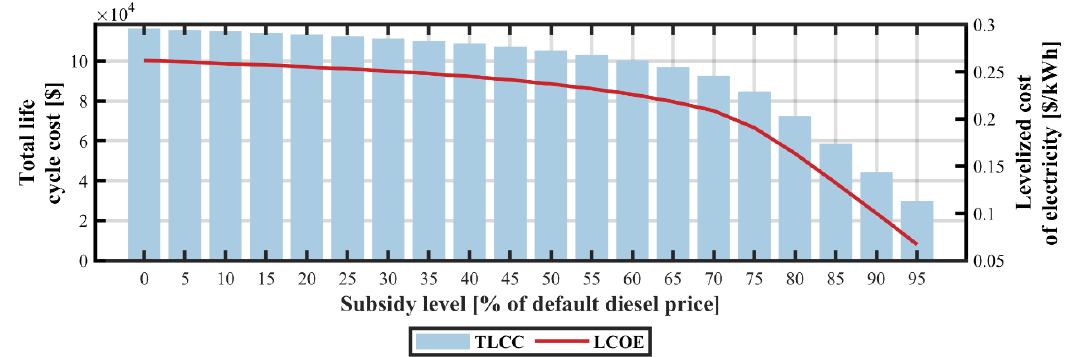
Figure 18. Simulation results of diesel fuel subsidies. Impact on LCOE and TLCC. Energies 2020 , 13 , x FOR PEER REVIEW